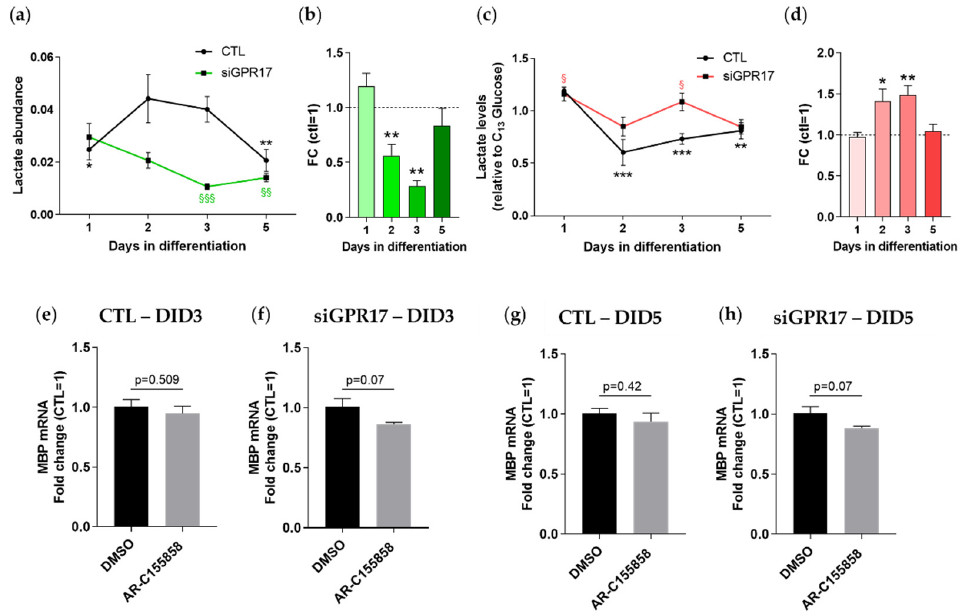
Figure 6. GPR17 silencing in OPCs alters lactate metabolism. ( a ) Lactate abundance during OPC maturation in control conditions (green line) and after GPR17 silencing (orange line). n = 7–9 per each group. One-way ANOVA with Tukey’s multiple comparisons test. * p < 0.05, ** p < 0.01 vs. DID2 CTL; §§ p < 0.01, §§§ p < 0.001 vs. DID1 siGPR17 ( b ) Lactate levels after GPR17 silencing were normalized versus control samples (set to 1) at each time point ( n = 7–9). ** p < 0.01; one sample t-test. Conditioned media from GPR17-silenced and control OPCs were collected from the same culture used for metabolomic analysis. Lactate levels in the media were evaluated by LC-MS/MS. ( c ) Abundance of lactate in the extracellular space during OPC maturation in control conditions (green line) and after GPR17 silencing (orange line). One-way ANOVA with Tukey’s multiple comparisons test. ** p < 0.01, *** p < 0.001 vs. DID1 CTL; § p < 0.05 vs. DID5 siGPR17. ( d ) Extracellular lactate levels after GPR17 silencing were normalized versus control samples (set to 1) at each time point. * p < 0.05; ** p < 0.01; one sample t -test. The effect of MCT1 inhibition in control ( e , g ) and GPR17-silenced ( f , h ) OPCs has been evaluated by analyzing the expression of MBP, in inhibitor-treated samples vs. relative controls (vehicle treated), at at 3 and 5 days of differentiation. n = 6 per each